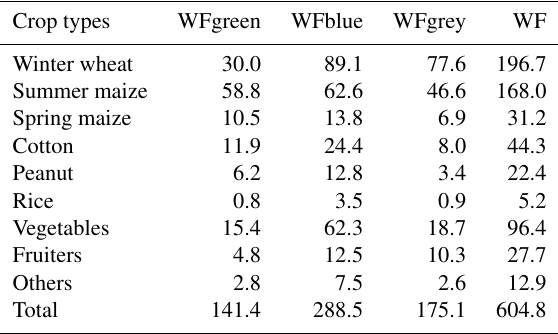
Table 5. WF (km 3 ) of each crop in the HSP from 2000 to 2012.